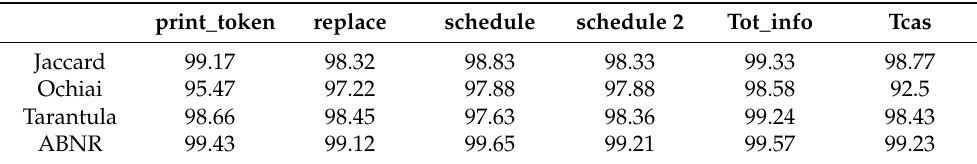
Table 8. Denote the confidence level of fault detection from Siemen’s validation set.